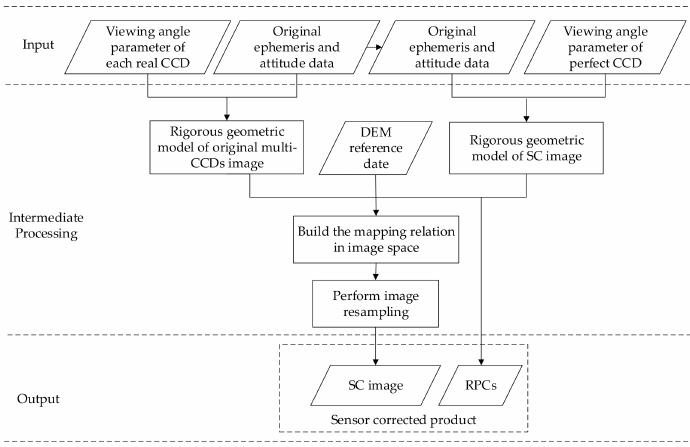
Figure 5. Workflow for the generation of a sensor corrected